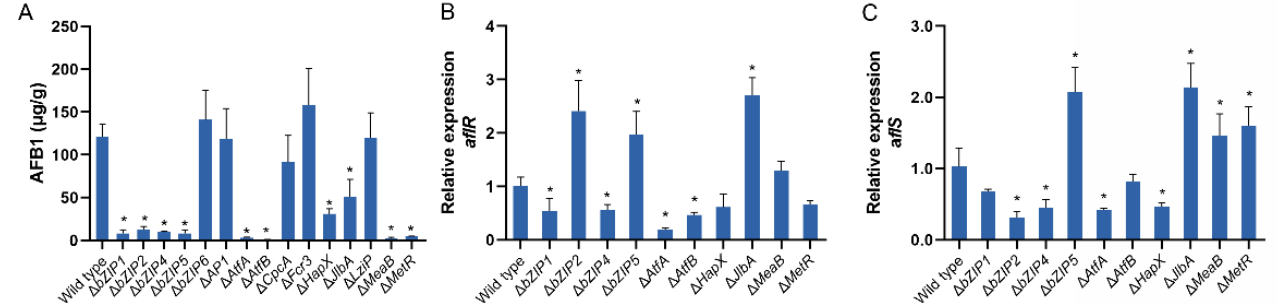
Figure 7. Analysis of the biosynthesis of aflatoxin by Aspergillus flavus strains. ( A ) Aflatoxin produc- tion by the A. flavus strains. Conidia of the indicated strains were inoculated on YES media. The production of AFB1 was determined using HPLC after 4 days of incubation at 28 °C. The relative levels of expression of aflR ( B ) and aflS ( C ) in mutants with reduced aflatoxin production. Error bars represent the SD. * p < 0.05, significant difference from the wild-type group as estimated by a Dunnett test. AFB1, aflatoxin B1; HPLC, high pressure liquid chromatography; SD, standard deviation; YES, yeast extract with supplements.